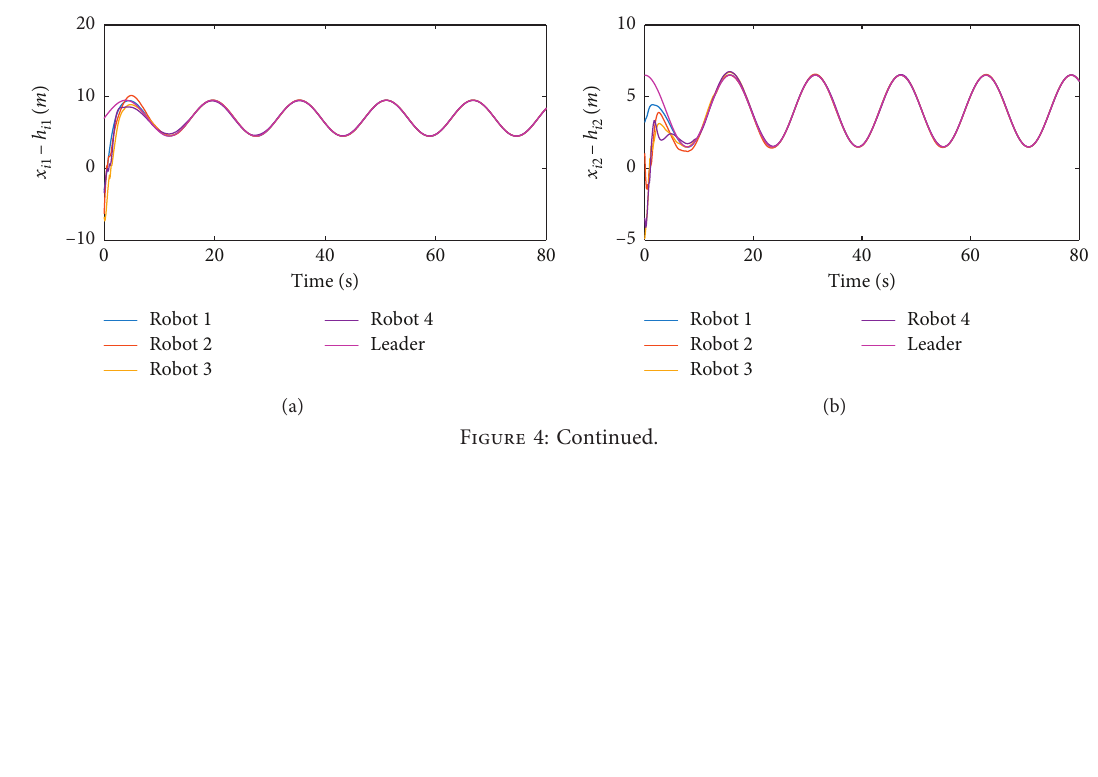
Figure 3: Evolution of e